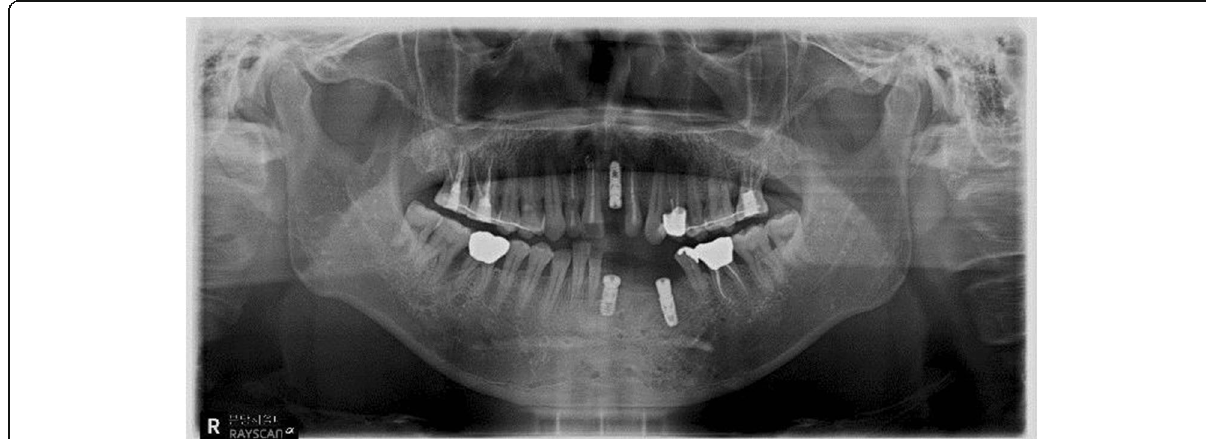
Fig. 7 Panoramic radiograph after implant placement